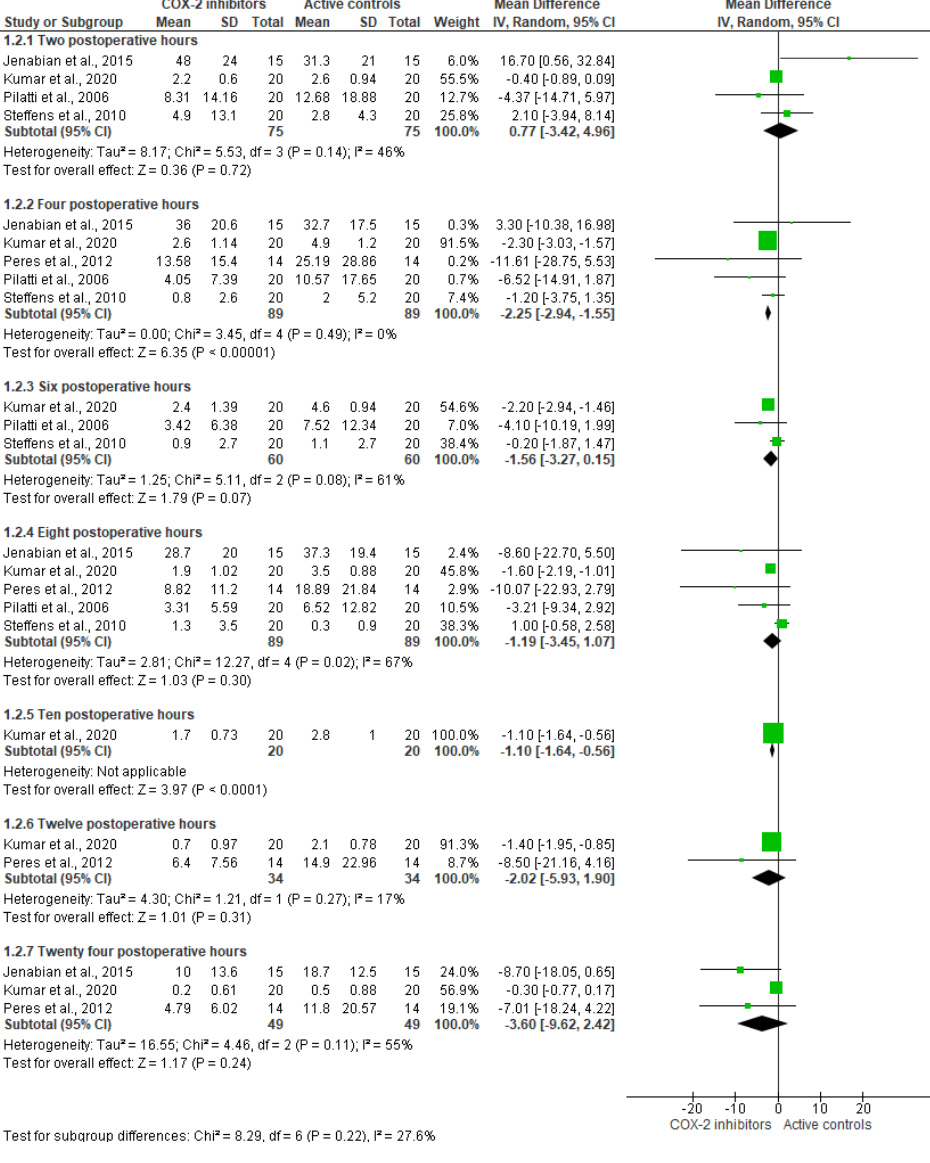
Figure 5. Postoperative pain control using COX-2 agents versus active controls in periodontal